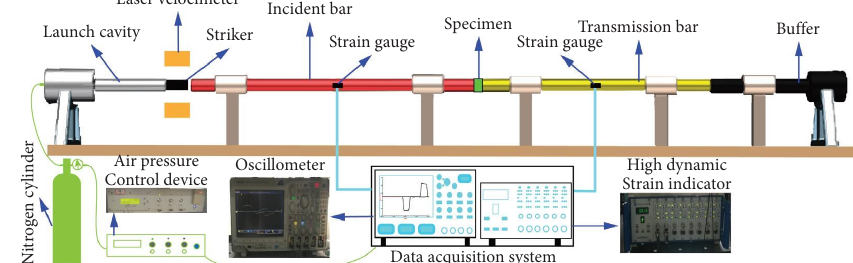
Figure 3: Schematic diagram of the SHPB test device.